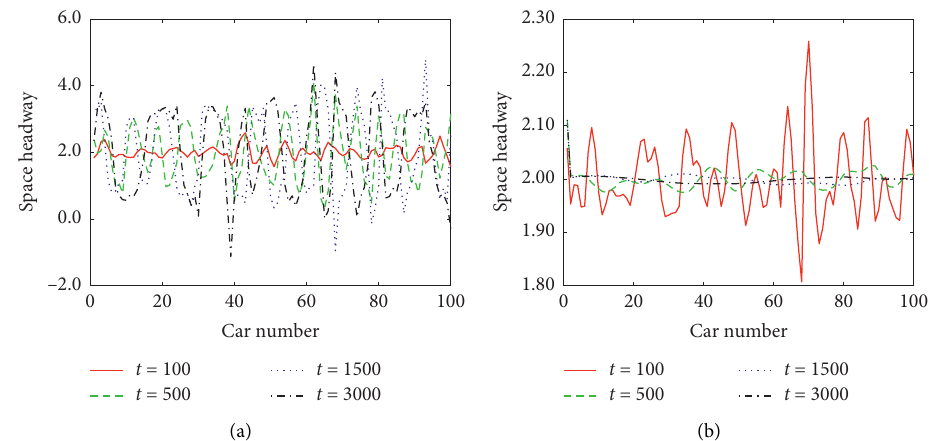
Figure 8: Profiles of space headway at time step t � 100, 500, 1500, and 3000 when κ obeys log-normal distribution. (a) OVM. (b)